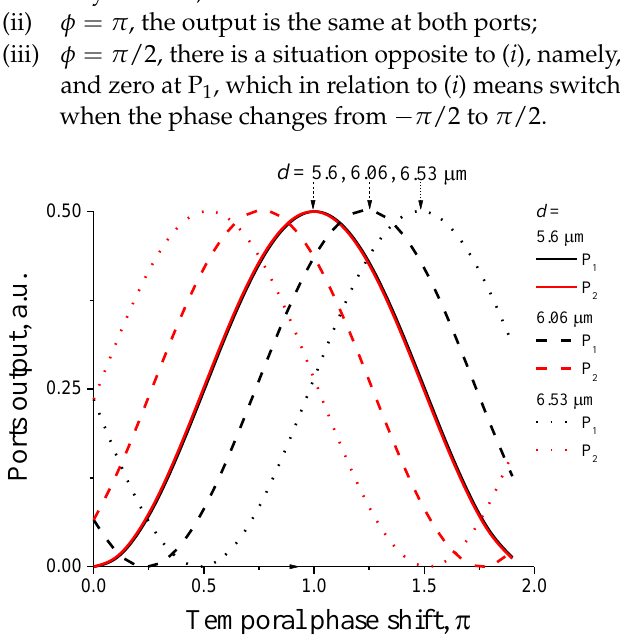
Figure 4. Output at ports P 1 and P 2 as a function of the phase shift φ between the two sources S 1 and S 2 , and for different distances d corresponding to the spatial phase shifts: 0, − π /2 and ± π . Notice that the red and black solid lines (corresponding to d = 5.6 µ m) are superposed to each